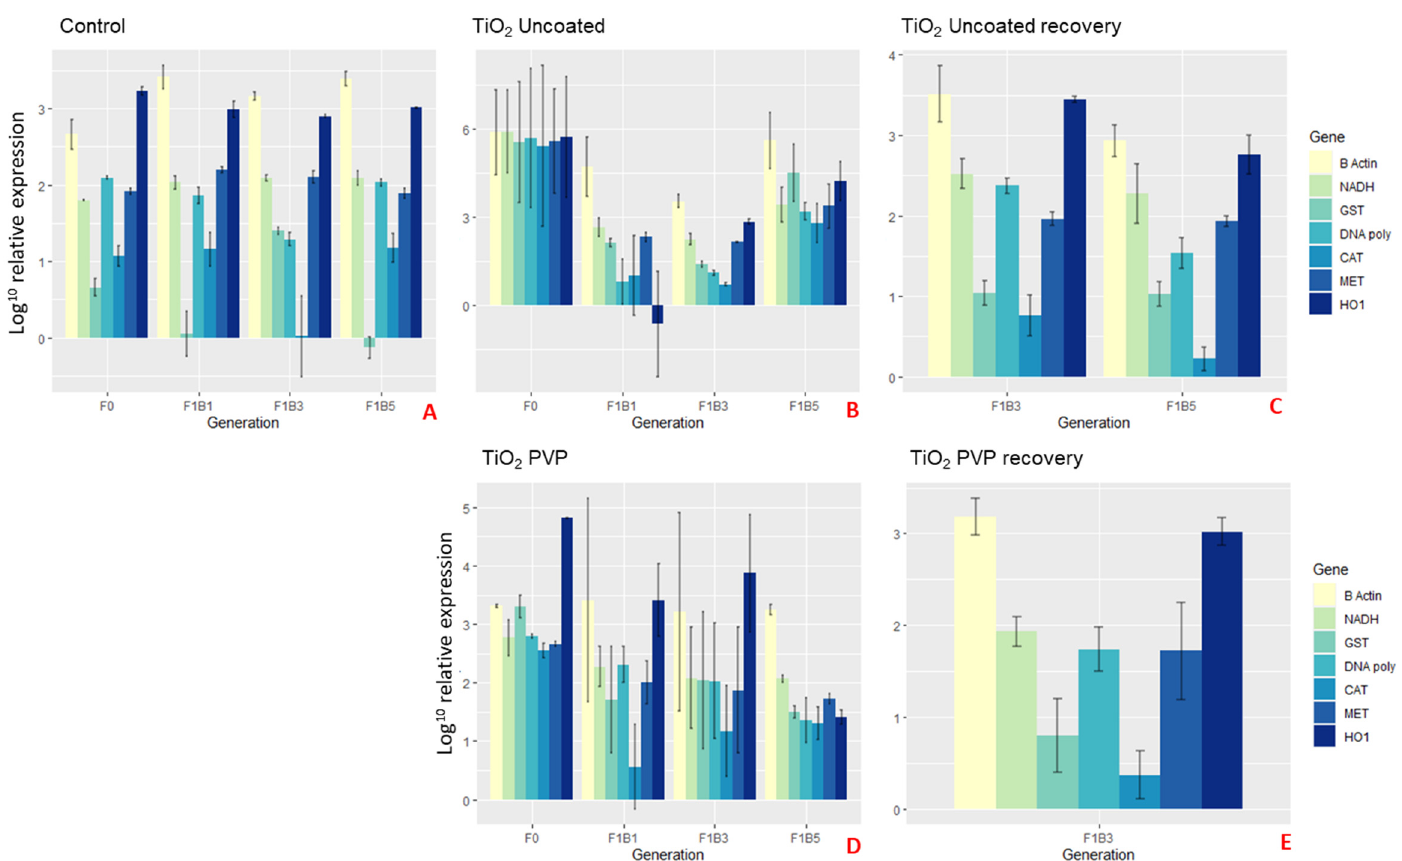
Figure 6. Gene expression barplots of the average relative expression (Log 10 ) for parent (F0) Daphnia that are ( A ) control, or exposed to the different TiO 2 NMs ( B–D ), and the relative gene expression levels of the first (F1B1), third (F1B3) and fifth (F1B5) broods born of the F0 parent in either continuous ( B and C ) or removed ( C and E ) exposure determined after 24 h. Error bars show the standard deviation and the NM gene interaction statistics are presented in Supplemental Table S. p ≤ 0.05 was considered statistically significant. Key = Glutathione S-transferase (GST), dehydrogenase (NADH), β -Actin (B-Actin), catalase (CAT), metallothionein (MET), DNA Polymerase (DNA-poly) and heme-oxygenase-1 (HO1). All genes are normalised to 18S ribosomal RNA (18S).